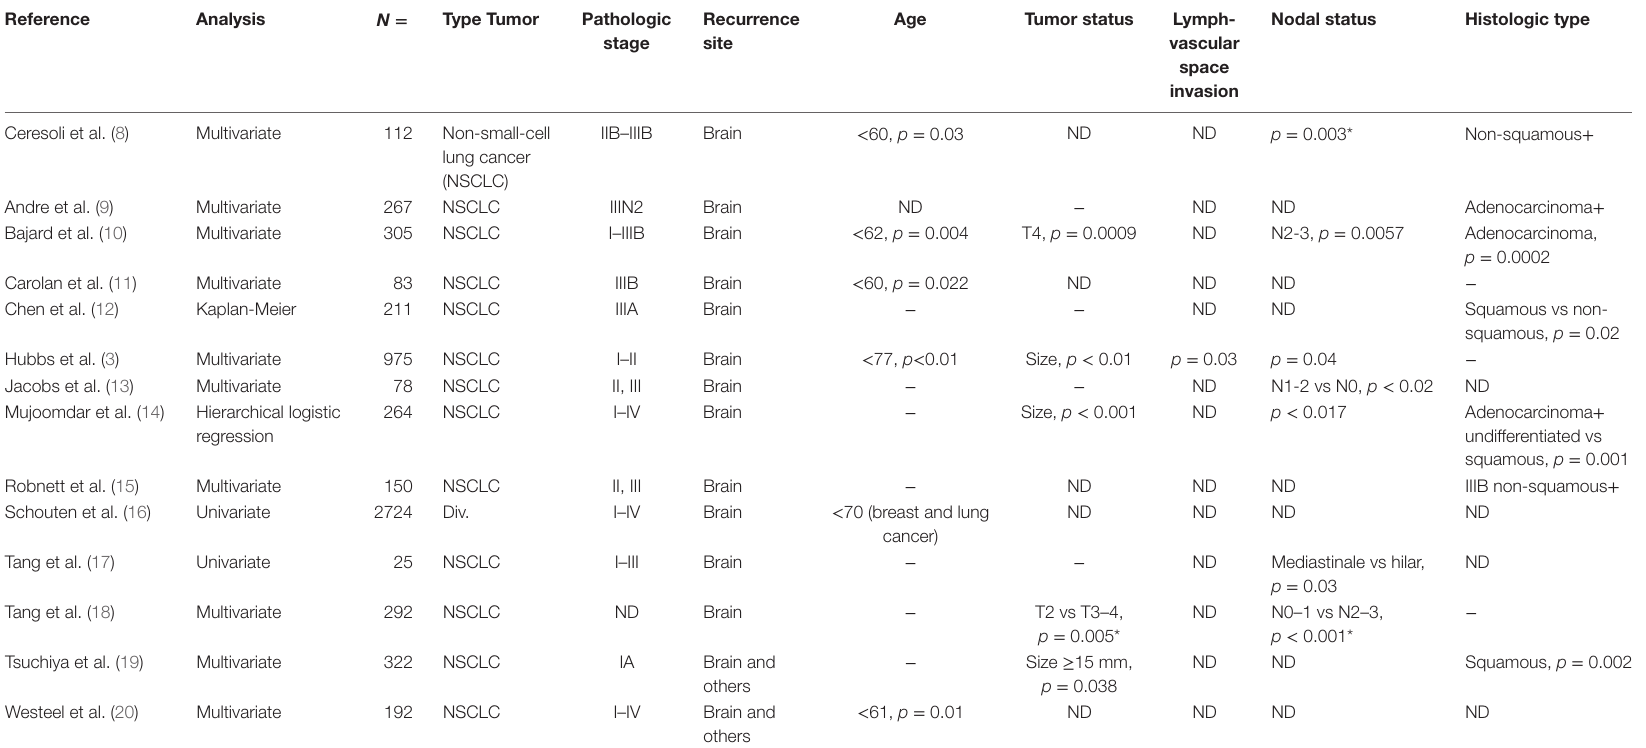
TaBLe 1 | Conflicting clinical and pathological risk factors associated with the development of brain